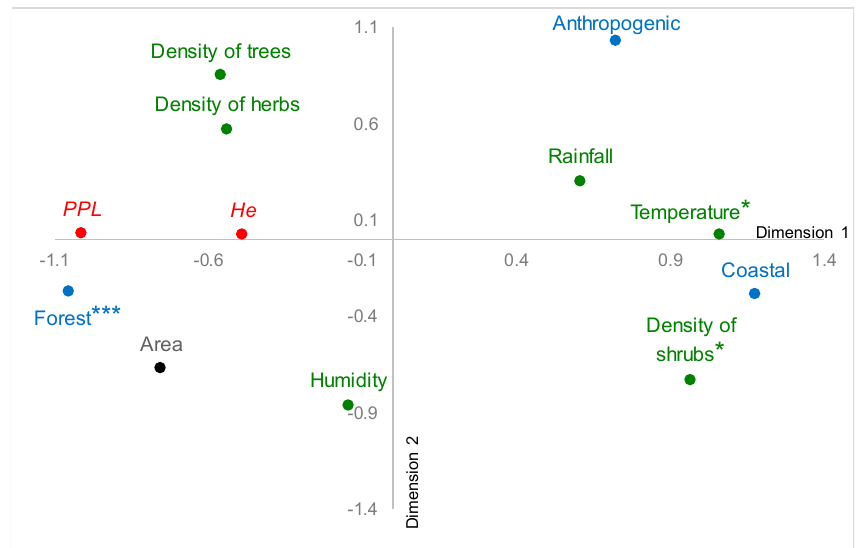
Figure 2. Multidimensional scaling analysis (MDS) considering the genetic diversity parameters in red color ( PPL and H e ), the land cover conditions in blue (forest, anthropogenic, and coastal areas), patches size in black, and environmental condition in green (humidity, temperature, rainfall, and density of shrubs, herbs, and trees). Significant results of Spearman correlation: *** p < 0.001, * p < 0.05.